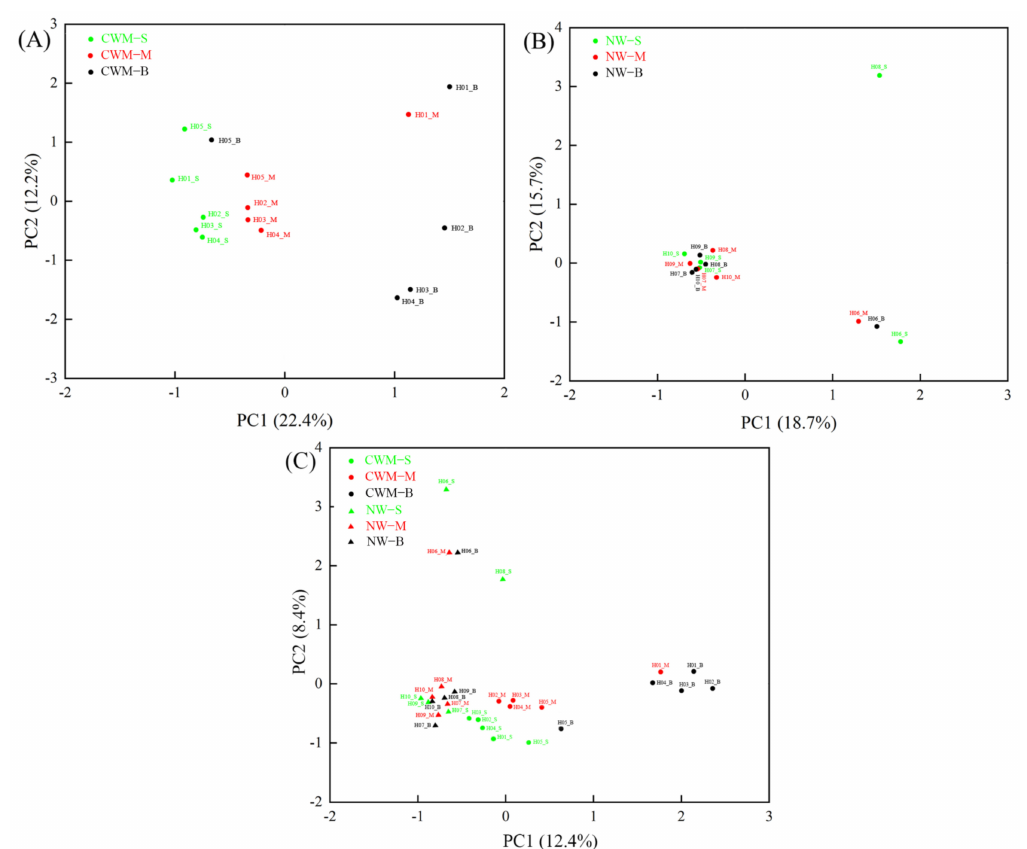
Figure 5. Principal component analysis (PCA) of eukaryotic plankton communities (genus level) according to the two populations (CWM and NW). Taxonomic (OTU) clustering based on unweighted UniFrac distances. ( A ): Principal compo- nent analysis of eukaryotic plankton communities in the CWM; ( B ): Principal component analysis of eukaryotic plankton community in the NW; ( C ): Principal component analysis of eukaryotic plankton community in the CWM and NW. CWM populations (CWM–S: surface; CWM–M: middle; CWM–B: bottom); NW populations (NW–S: surface; NW–M: middle; NW–B: bottom).